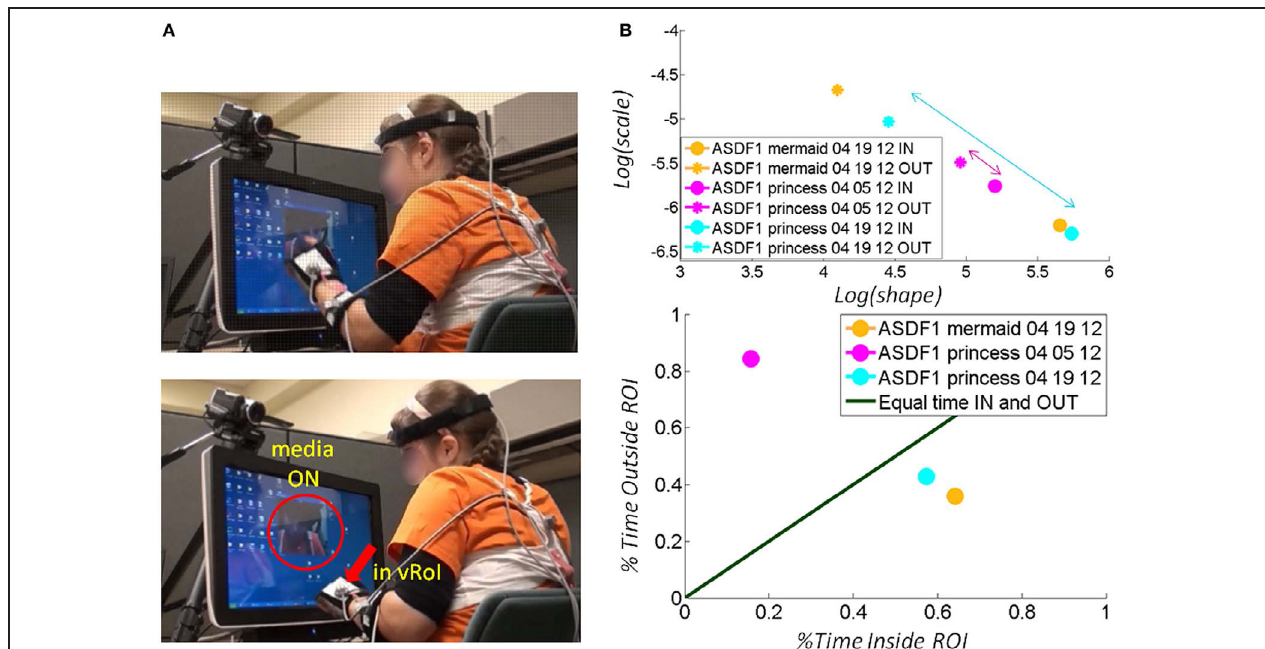
rate of change of the stochastic signatures speaks of their sensory preferences and adaptive capabilities. Longitudinally (from March to April) there is a shift for “The Disney Princesses” video (from magenta to cyan), but the shift in real time for “The Little Mermaid” is far more pronounced and occurs faster. This video was far more effective than “The Disney Princesses” video in shifting her stochastic patterns toward a more predictive behavioral regime. (C) Consistent with the largest shift toward the predictive regimes (preferred media) the child spends more time inside the vRoI with that media